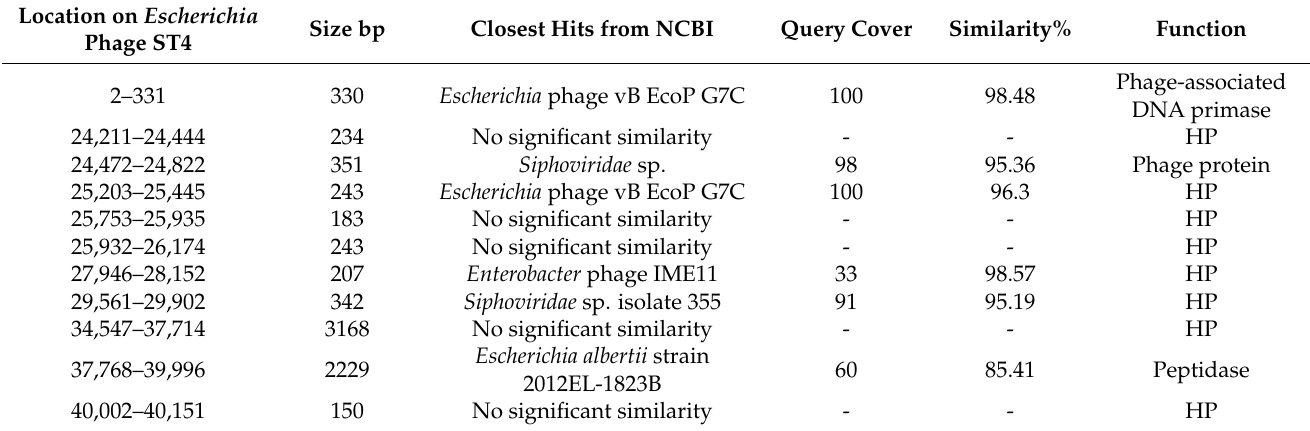
Table 7. Genes occurred in Escherichia phage ST4 and not present in Escherichia phage